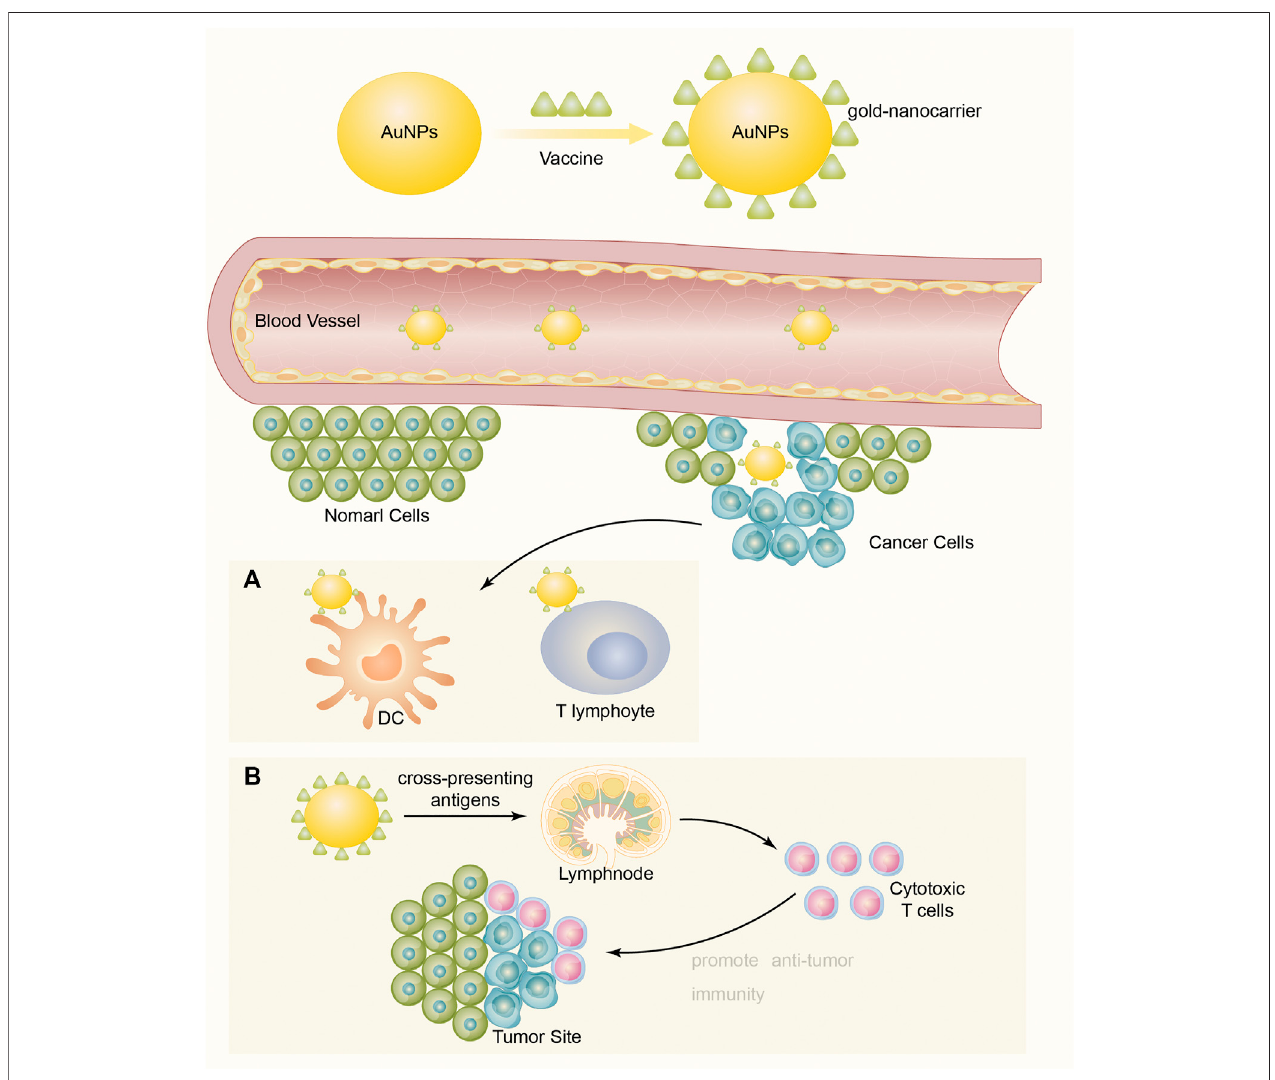
FIGURE 1 | Vaccines connect to and display on the surface of AuNPs to become a formation of vaccine-AuNPs complex, then the complex penetrates blood vessels and delivers vaccine targeting cancer cells to enhance immune response. (A) Targeting for delivery to dendritic cells (DCs) or T lymphocytes. (B) Cross-present antigens to more effectively stimulate cytotoxic T lymphocytes and to promote antitumor immunity.